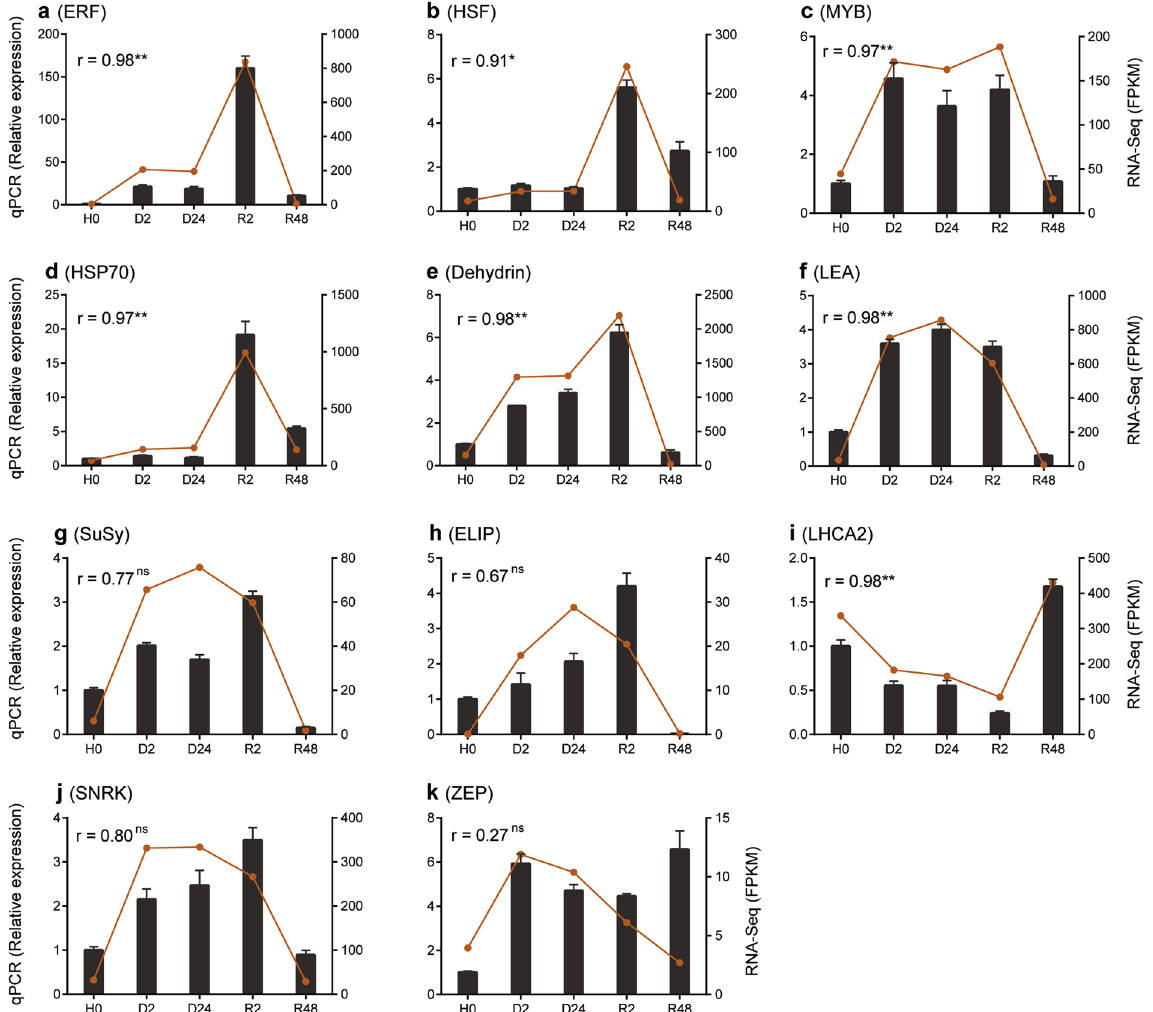
Figure 8. qPCR validation of interested genes in Bryum argenteum . Selected transcript abundance profiles were validated using quantitative real-time PCR (qPCR), including genes encoding ERF transcription factor ( a ), heat shock factor (HSF) ( b ), MYB transcription factor ( c ), heat shock protein 70 ( d ), dehydrin ( e ), late embryogenesis abundant (LEA)-like protein ( f ), sucrose synthase ( g ), early light induced protein (ELIP) ( h ), photosystem I light harvesting complex gene 2 (LHCA2) ( i ), protein kinase (SNRK) ( j ) and zeaxanthin epoxidase (ZEP) ( j ). qPCR quantitative gene expression data were shown as the mean ± SEM. Correlation of the expression levels evaluated using qPCR and RNA-Seq was statistically assessed by the calculation of Pearson correlation coefficient (r) and P-value were also indicated ( ** P-value < 0.005, * P-value < 0.05, ns: not significant or P-value >